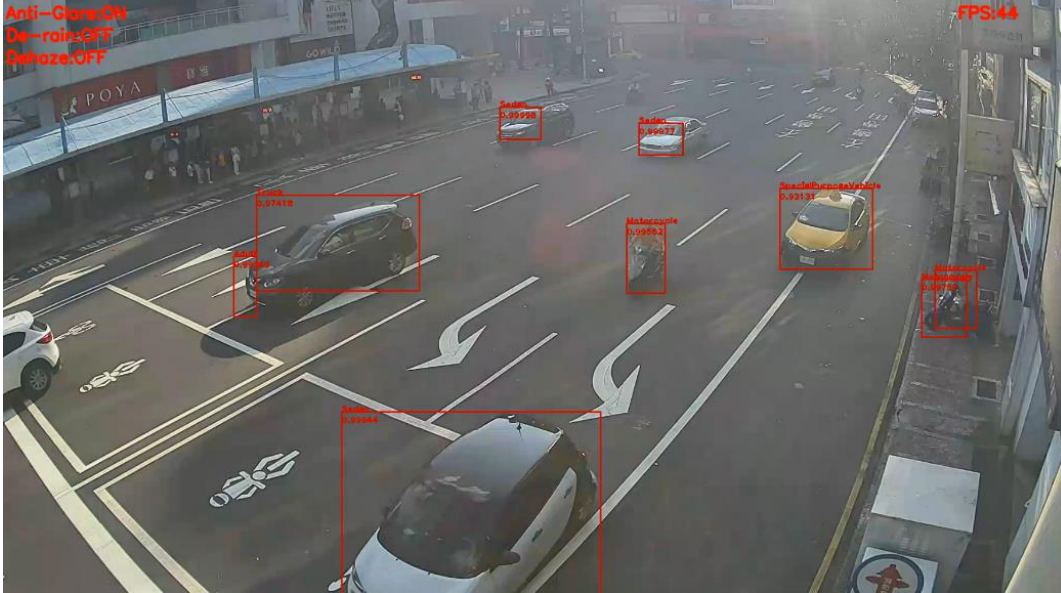
Figure 25. Low-contrast scene image frame detected by our proposed system.